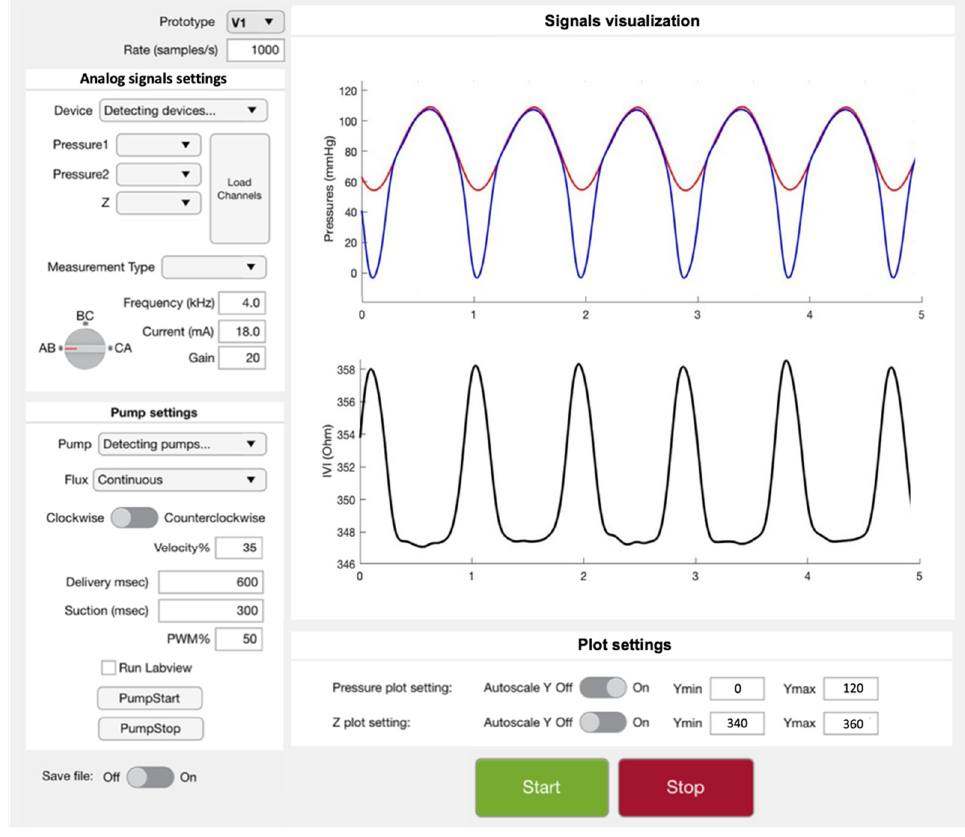
Figure 9. Graphic User Interface (GUI) implemented in MatLab AppDesigner.